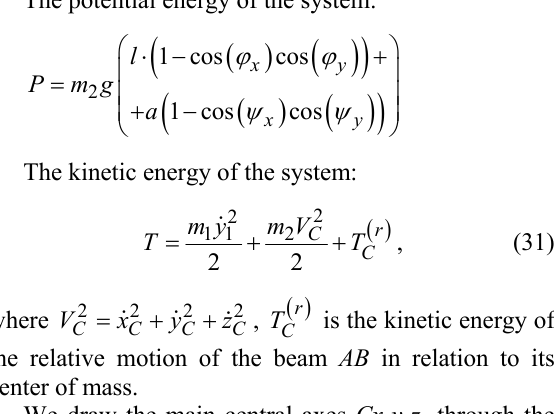
Figure 15. Scheme of the second rotation around the axis 3 Cy at the angle x